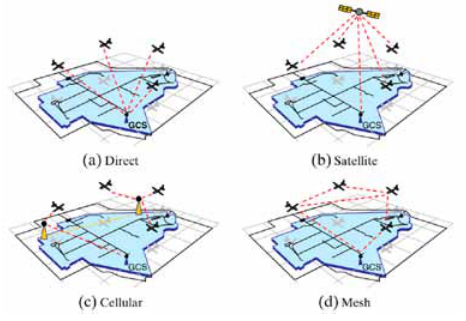
Fig. 2. RPV’s types of telemetry (Frew, Brown 2008)